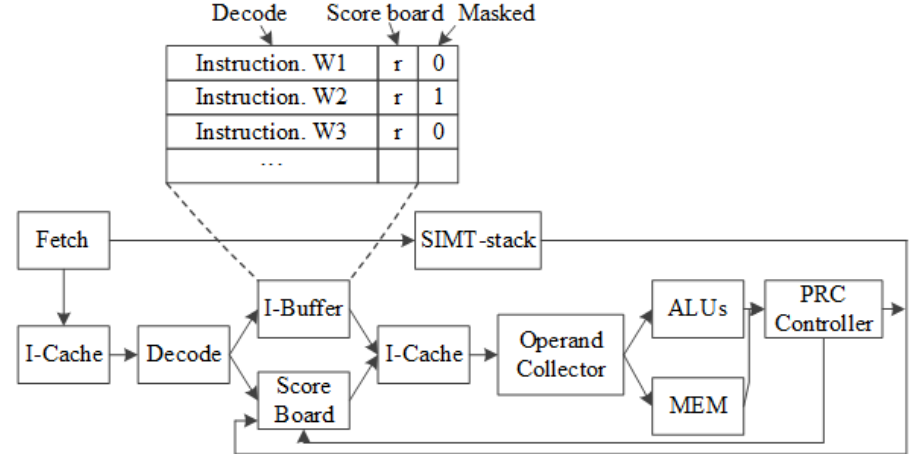
Figure 6. Single instruction, multiple threads (SIMT) core pipeline flow with a scoreboard data-hazard